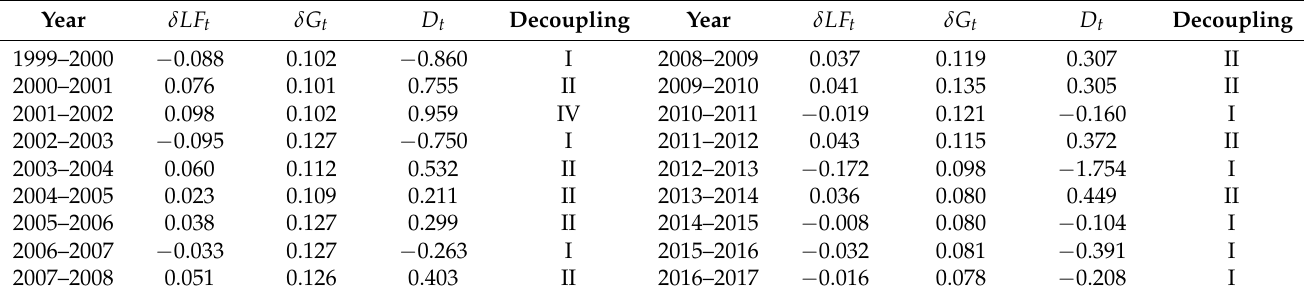
Table 2. Decoupling state between land natural capital utilization and economic growth from 1999 to 2017.